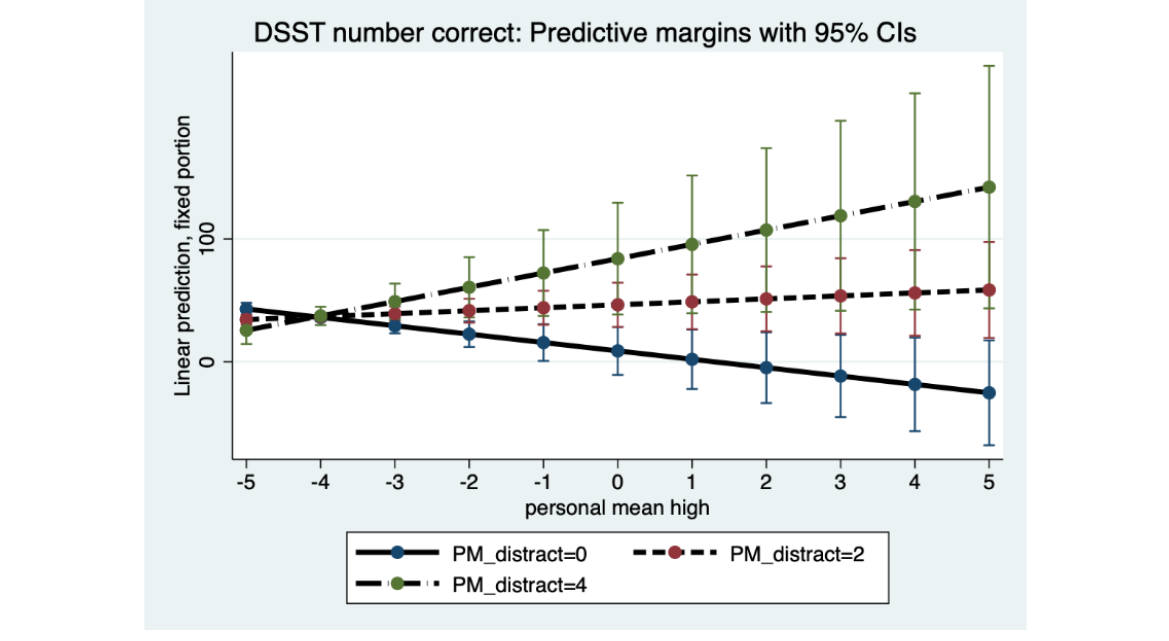
Figure 7. Digit symbol substitution task: distraction person mean (PM) as a moderator of the association between subjective high PM and number of correct responses. Distraction PM at low (0), moderate (2), and high levels (4). DSST: digit symbol substitution task; PM: person